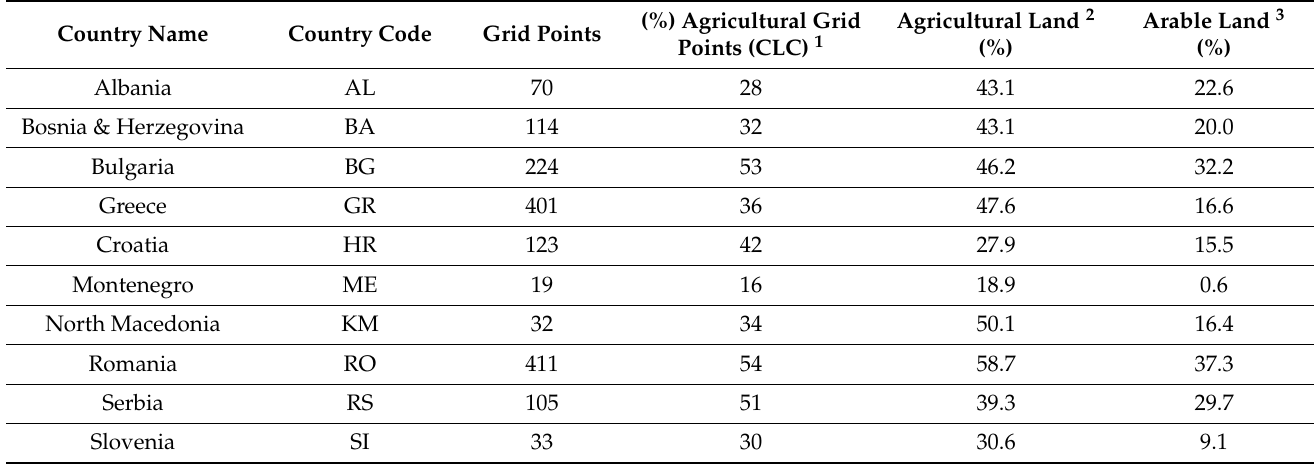
Table 1. Study area’s information about the total and agricultural area’s grid points and the percentage of the arable land per